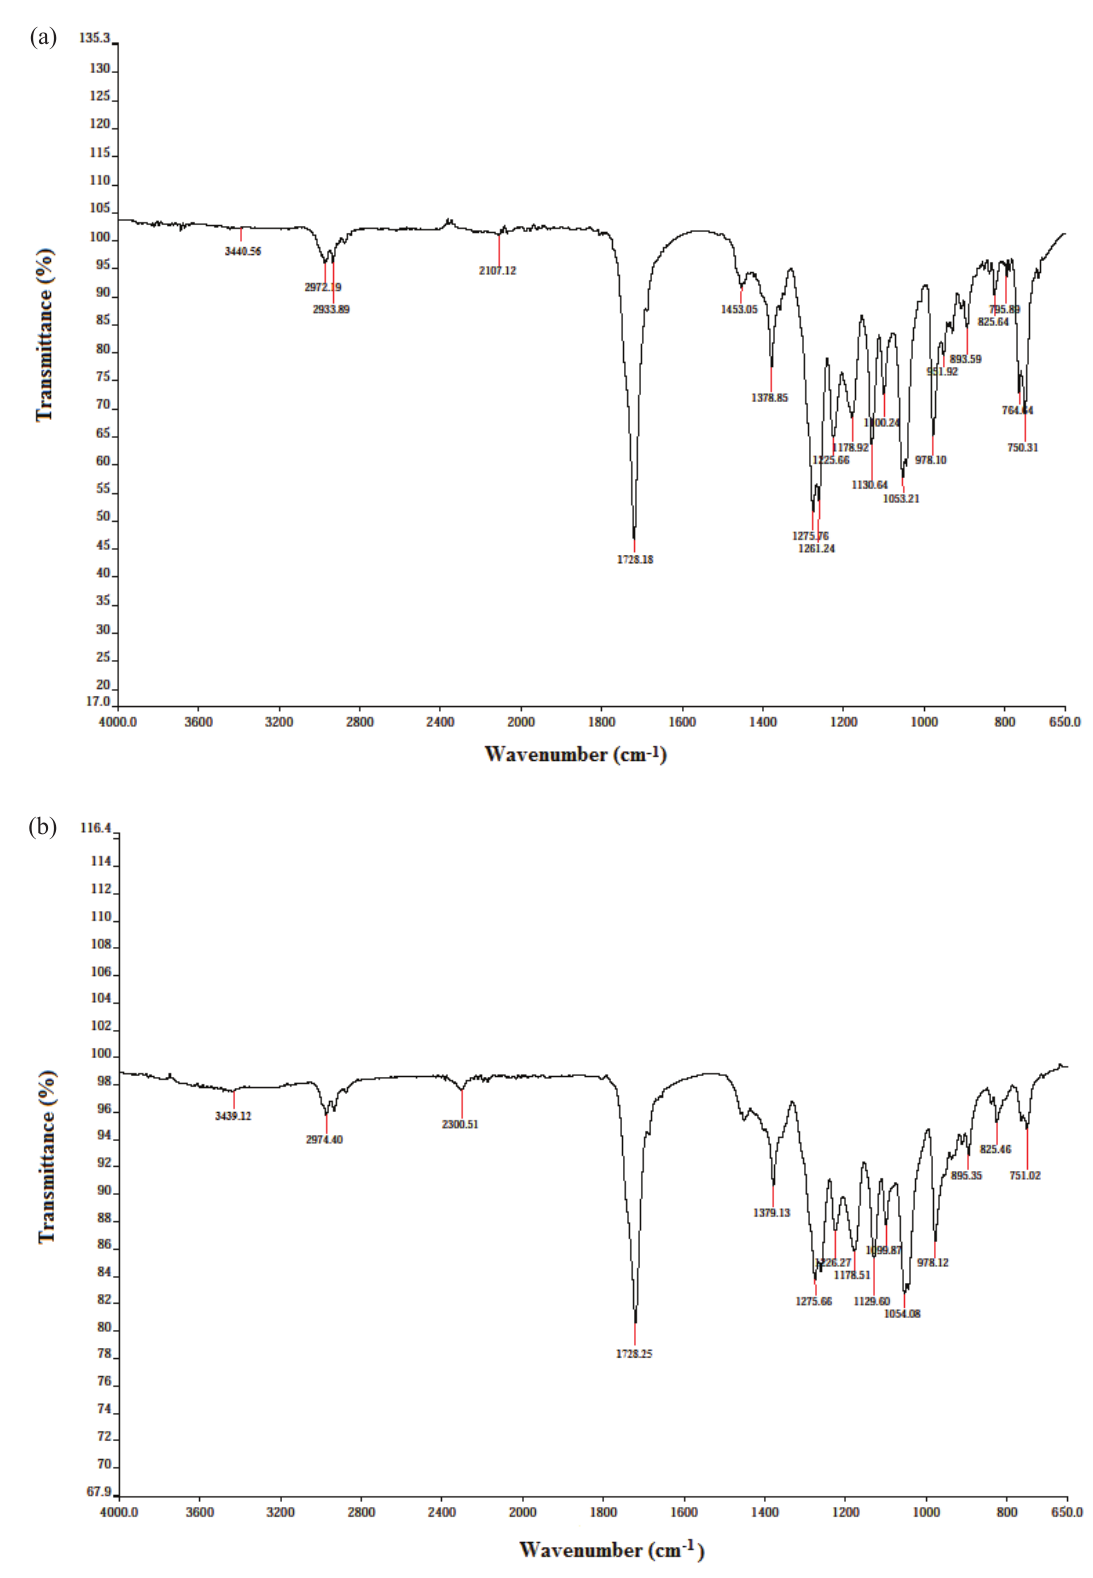
Fig. 4 – FTIR spectra of a) standard poly(3HB-co-12 %-3HV), and b) copolymer extracted from C.